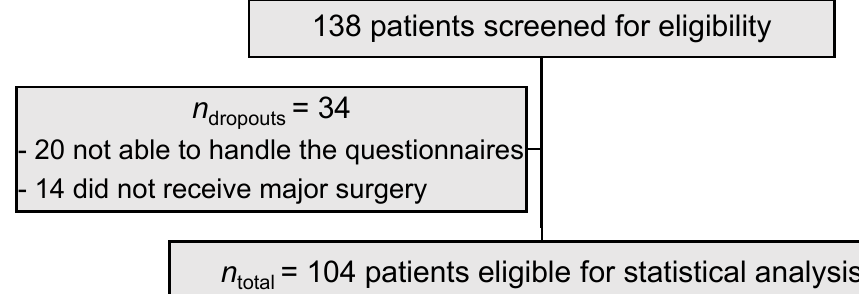
Figure 1. Patient selection.